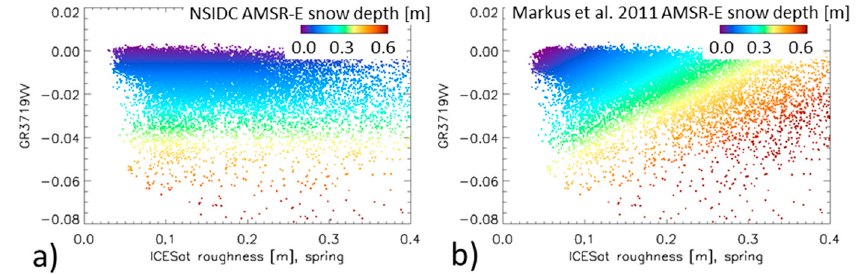
Figure 5. The distribution of the snow depth (color-coded dots) in the GR3719VV–ICESat elevation STDDEV space. ( a ) The NSIDC AMSR-E snow depth; and ( b ) the Markus et al. [22] hybrid AMSR-E snow depth.